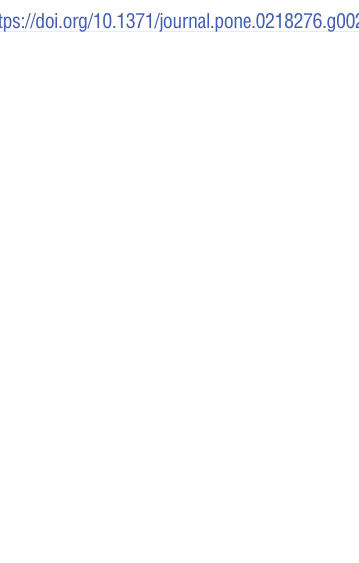
Fig 2. Pollen grain in polar view; convex operculum visible in middle of narrow